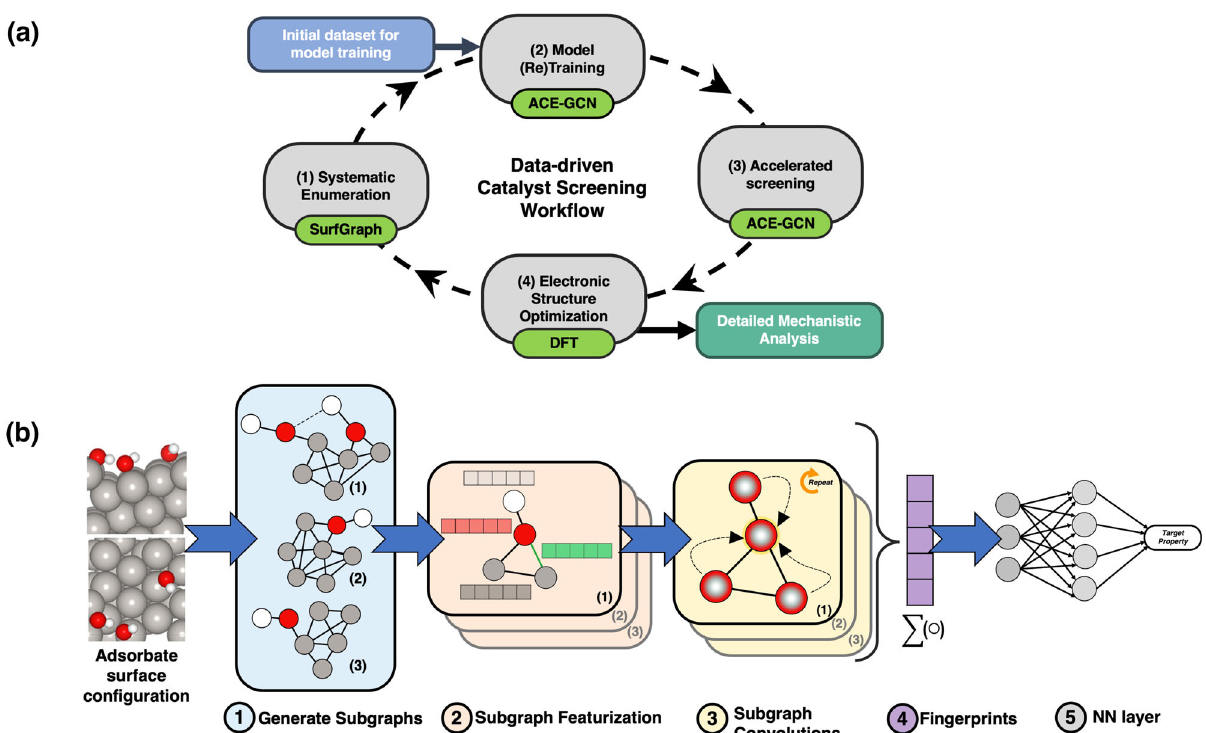
Fig. 1 | Catalyst screening work fl ow and overview of the ACE-GCN algorithm. a Screening work fl ow for identifying stable surface adsorbate con fi gurations. The work fl ow demonstrates an incremental training approach to predict thermo- dynamically stable catalytic con fi gurations. The cyclic work fl ow includes the fol- lowing steps: (1) Systematic enumeration: all possible and unique high coverage surfaceadsorbaterepresentationsaregeneratedusingtheSurfGraphalgorithm,(2) Model Training: the ACE-GCN model is (re)trained on selected structures utilizing the relevant surface representations identi fi ed in the previous steps, (3) Acceler- atedscreening:theunrelaxedsurfacecon fi gurationsgeneratedinstep1areranked usingtheACE-GCNmodel,whichispre-trainedonasmallersubsetofrelevantDFT- relaxed case, and (4) Electronic structure optimization: selected unrelaxed con- fi train and improve the ACE-GCN model. b ACE-GCN algorithm to encode and train high coverage adsorbate con fi gurations. (1) Generate subgraphs: each